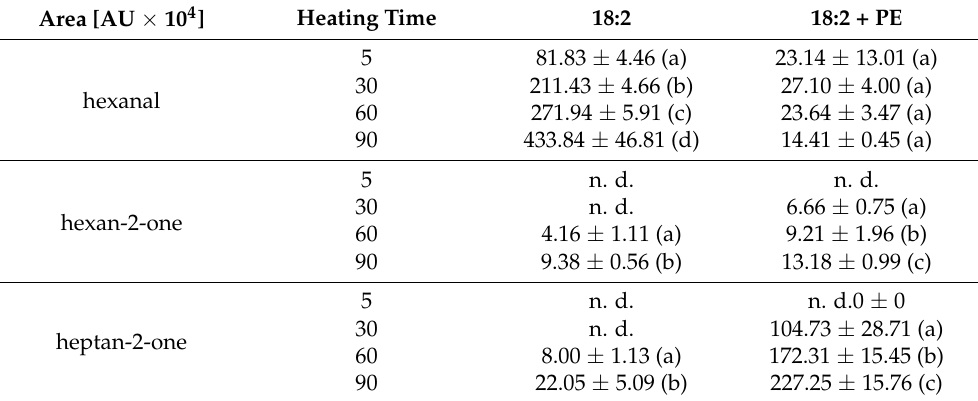
Table 2. Comparison of peak areas of formed carbonyl compounds from 0.1% linoleic acid with 18:2 + (PE) and without PE (18:2) heated at 160 ◦ C for 5–90 min and analyzed by HS-GC-MS; n. d. = not